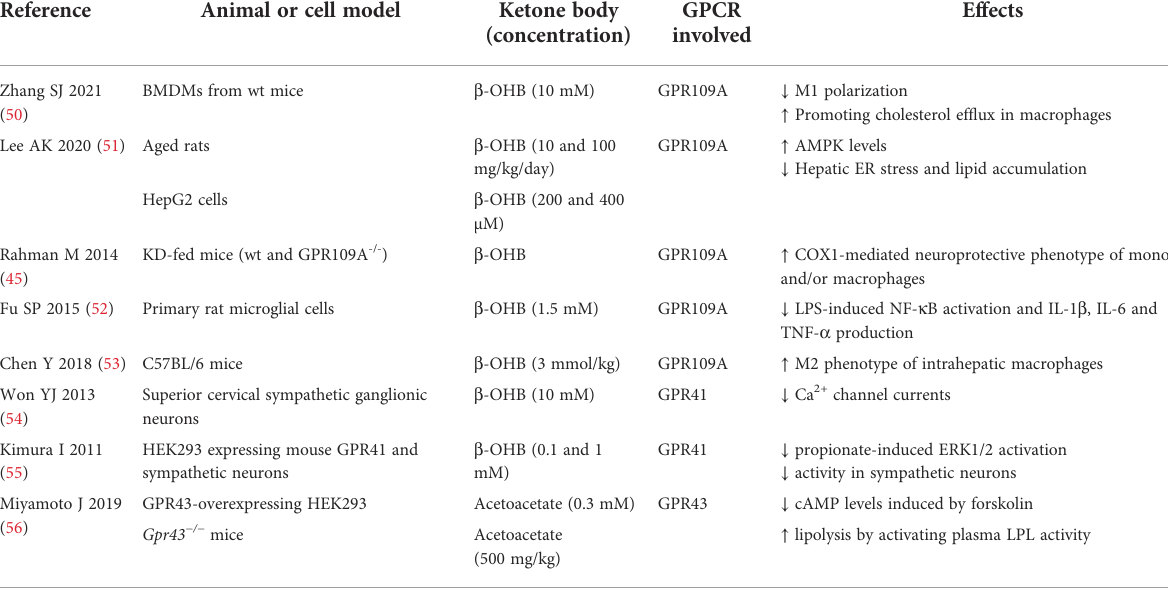
TABLE 1 Summary of studies on GPCR-mediated actions of ketone